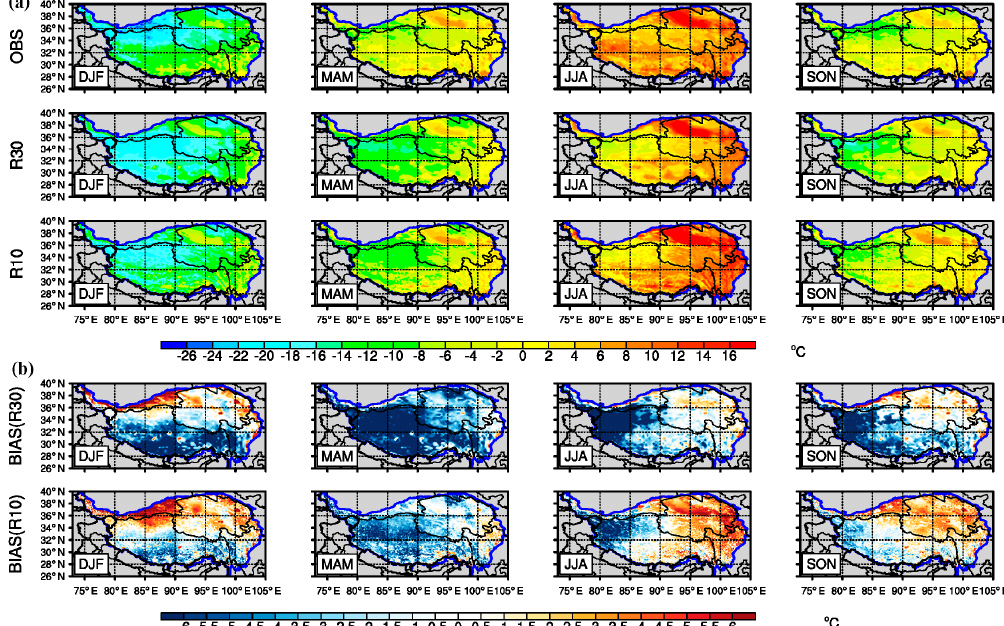
Figure 2. The spatial distribution of simulated seasonal mean temperature ( a , top panel ) and mean biases ( b , bottom panel ) between the simulations and observations for 1980 − 2010. Table 2. The mean bias (BIAS), root mean square error (RMSE), and the spatial correlation coefficients (SCOR) for seasonal temperature and precipitation between RegCM4 simulations and the observation. Temperature (°C)